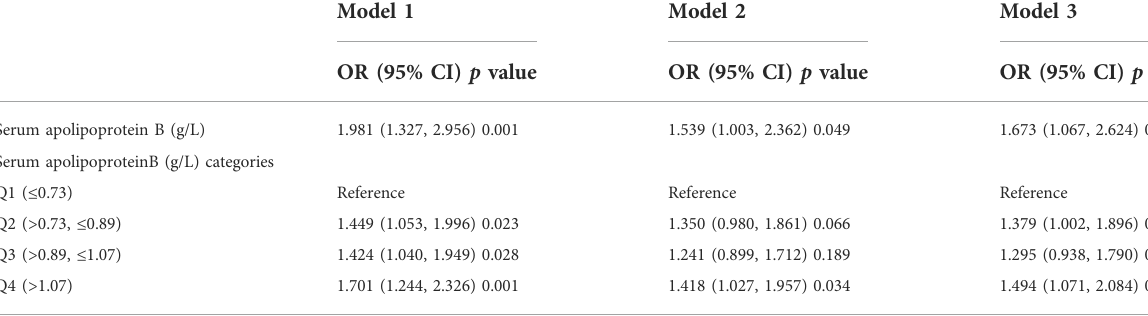
TABLE 6 Association between Serum apolipoprotein B (g/L ) and the risk of osteopenia or